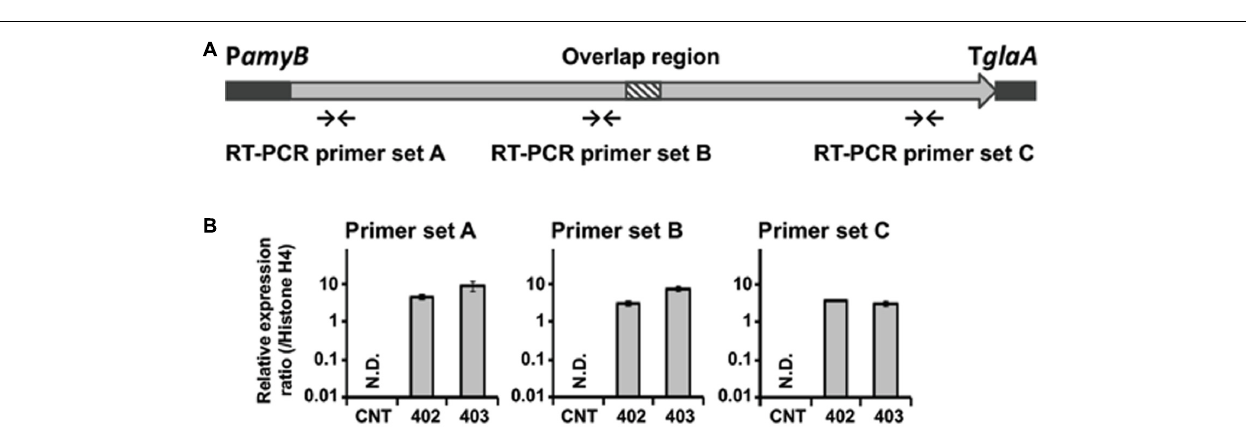
FIGURE 3 | Expression of the NRPS gene in A. oryzae . (A) Arrows indicate regions of primer binding for qRT-PCR analyses. (B) Expression of the NRPS gene in the A. oryzae CNT strain and in strains NRPS-402 (402) and NRPS-403 (403) grown for 24 h in YPM medium. qRT-PCR was used to determine the levels of transcription of the NRPS gene by using primer sets A–C. Each value represents the ratio of expression to that of the histone H4 gene. Error bars represent standard deviations (three biological and two technical replicates). ND, not